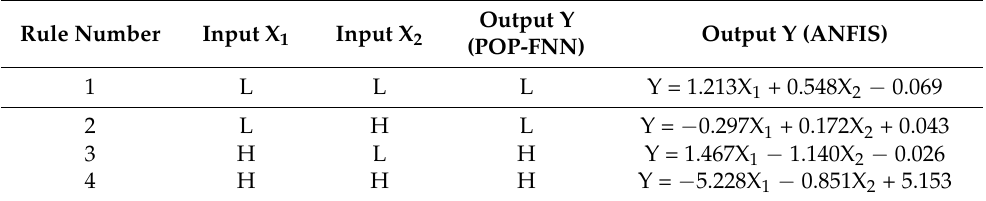
Table 2. Sample extracted rules from POP-FNN and ANFIS rainfall–runoff models for two rainfall inputs and flow as output when two fuzzy labels of low (L) and high (H) are